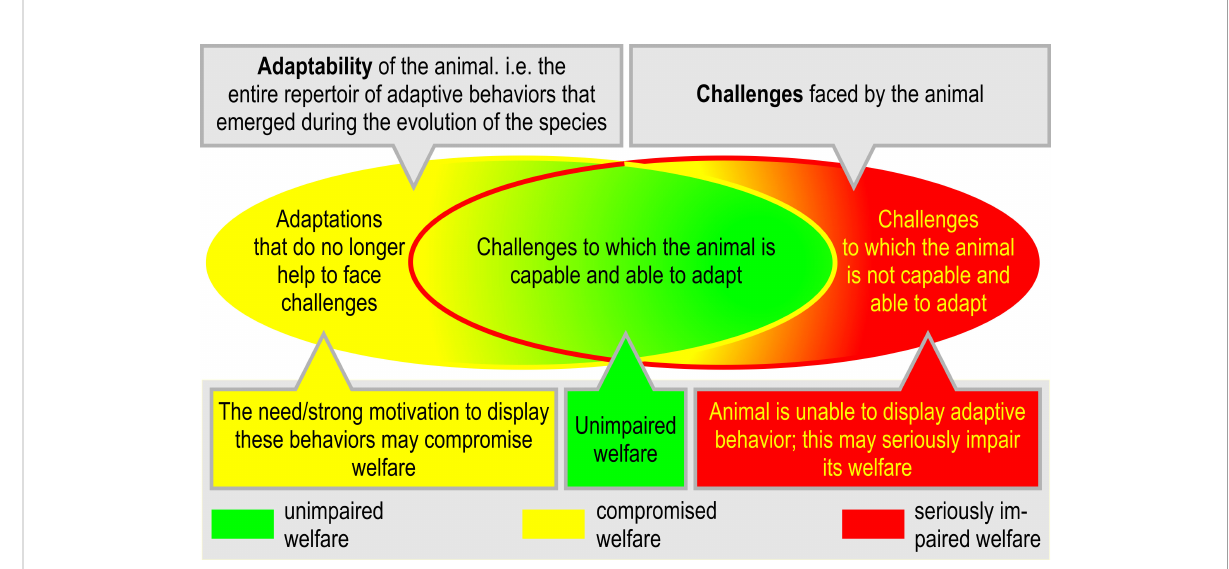
FIGURE 5 The mismatch between behavioral adaptability and challenges and the consequences of failing or succeeding to adapt. If an animal ’ s capacity and/or ability to adapt and cope with adverse internal and/or external factors is exceeded, the animal may be confronted with (unsolvable) problems (inspired by and modi fi ed from Fraser et al., 1997, p.